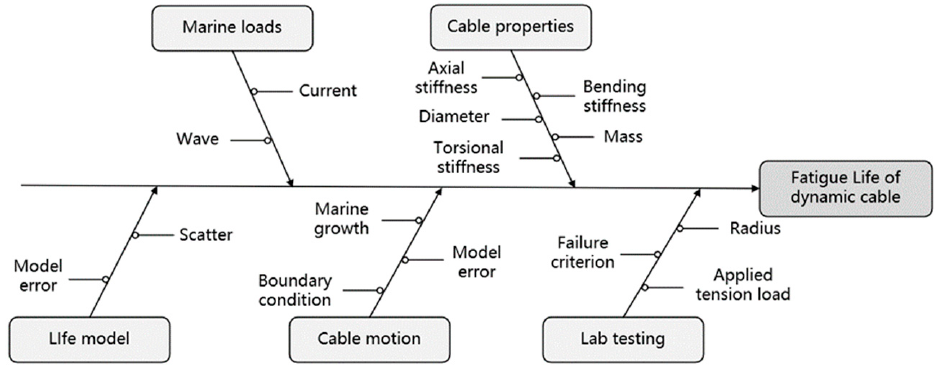
Figure 6. Ishikawa diagram [32] for the given uncertainty sources for the VMEA application of flexible power cable reliability and fatigue assessment process design.